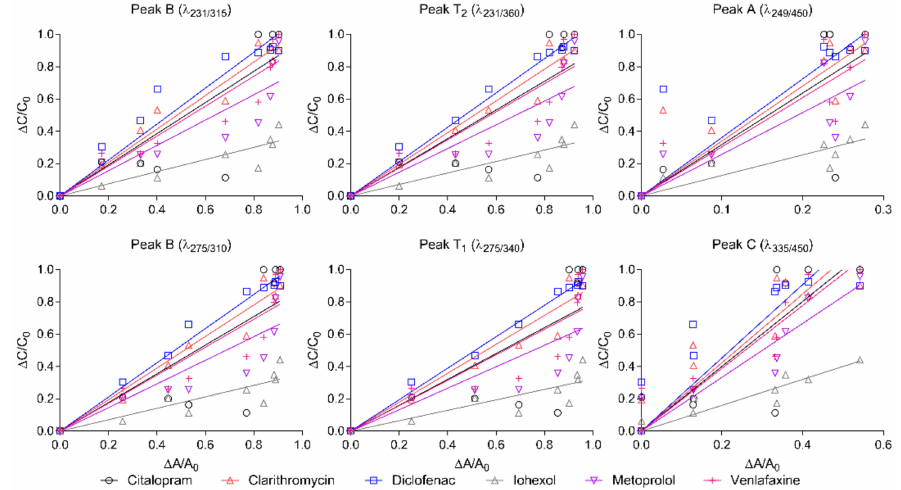
Figure 4. Correlation between changes in concentrations of selected pharmaceuticals ( ∆ C / C0) and relative changes in excitation emission matrices fluorescence ( ∆ A / A0) under di ff erent dosages of ozone in the laboratory, fitted by the straight